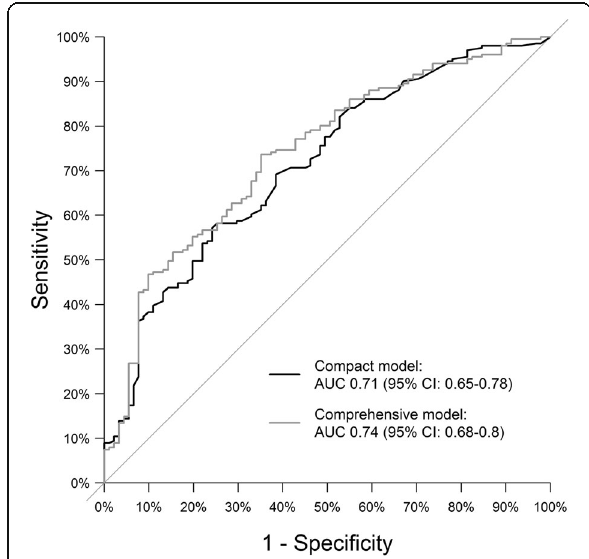
Fig. 2 ROC curves of the prediction models. The black line corresponds to the compact model, and the grey line to the comprehensive model (AUC, area under the curve; CI, confidence interval; p -values comparison to AUC = 0.5)